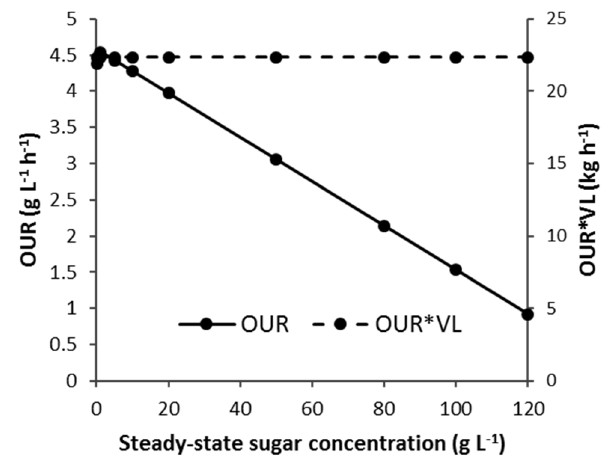
Figure 6. Effect of CSTB steady-state sugar concentration on oxygen uptake rate ( OUR ) and total oxygen uptake rate in the bioreactor volume ( OUR*V L ) [steady-state oxygen concentration is 2 mg · L − 1 ].